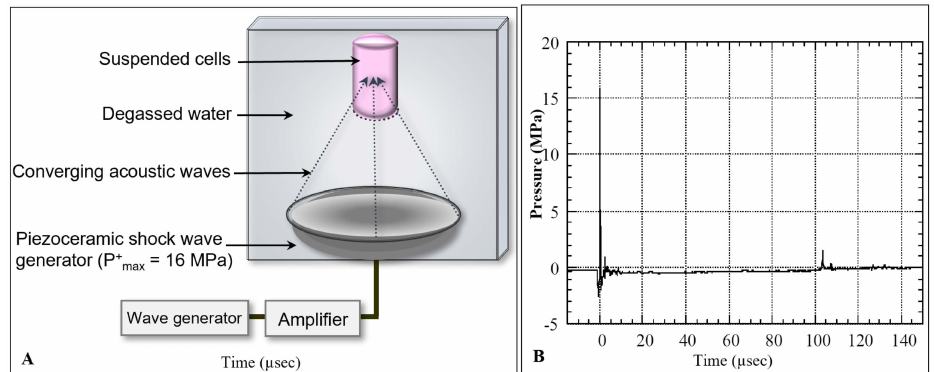
Figure 1. Schematic diagram of the shock wave experimental setup. ( A ) Suspended human renal carcinoma cells (TOS-1) were located in the focal area of a piezoceramic generator placed in a degassed water bath at 37 ◦ C. Cells were exposed to shock waves at 0.2-s intervals. ( B ) Pressure history of a shock wave generated in the focal area at a voltage discharge of 1.5 kV with maximum peak pressure of P + max = 16